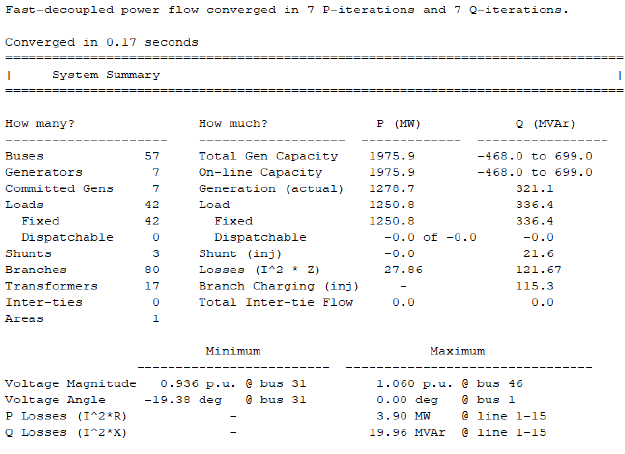
Figure 6. System summary and load flow analysis using Fast decoupled load flow